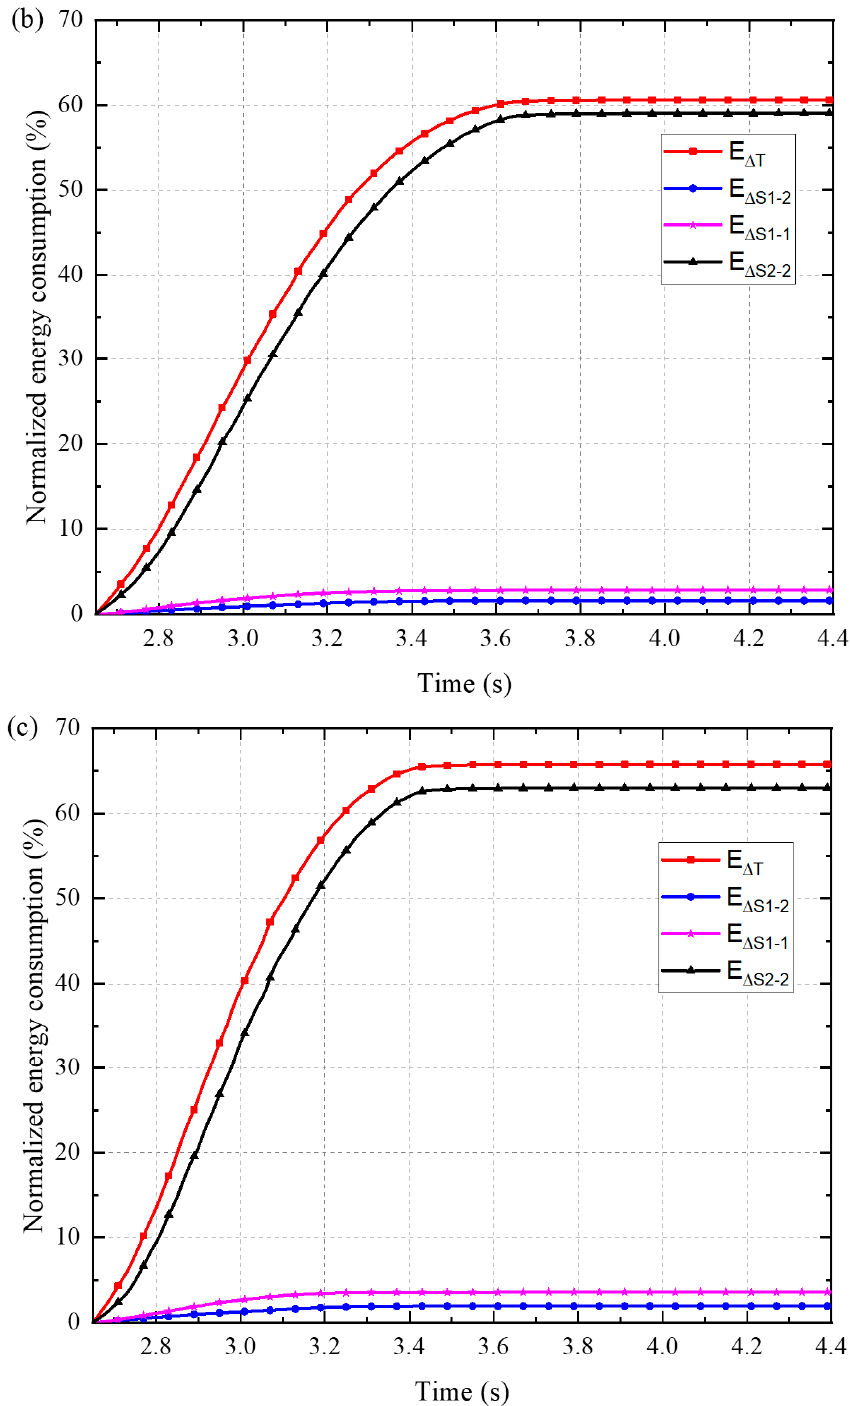
Figure 8. Energy consumption during the interaction process between surge2 and the dead zone formed by surge1. The slope angle is ( a ) 30 ◦ , ( b ) 35 ◦ and ( c ) 40 ◦ . The total surge volume is 39.6 L. The initial time is readjusted to t = 2.65 s when the front of surge2 reaches the tail of the dead zone, which means we focus only on the interaction process. Table 5. Energy consumption mode during the interaction process between surge2 and the dead zone formed by surge1.